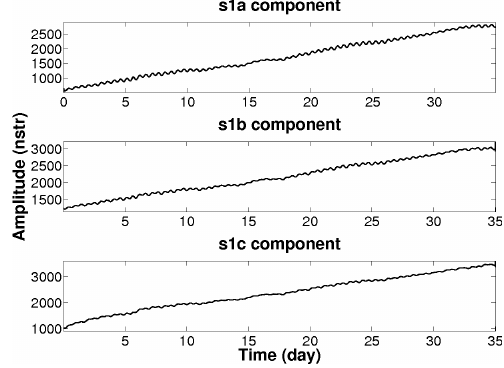
Figure 4. One month of MOK strain records on gauges s1a, s1b and s1c. The linear trend of each component is clearly visible, of the order of one tidal amplitude every day.